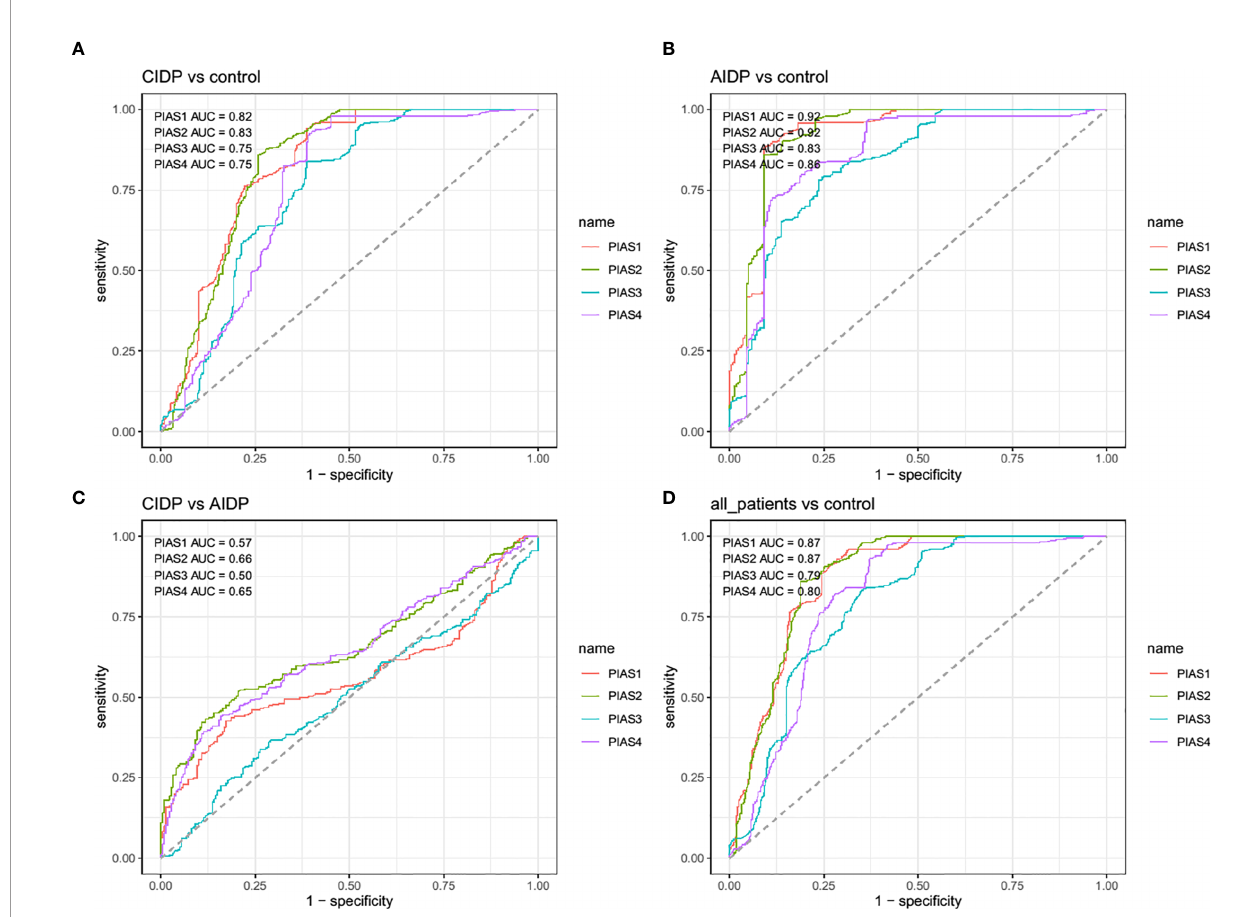
FIGURE 3 | The receiver operating characteristic (ROC) curve of PIAS1-4 in diagnosis of in fl ammatory demyelinating